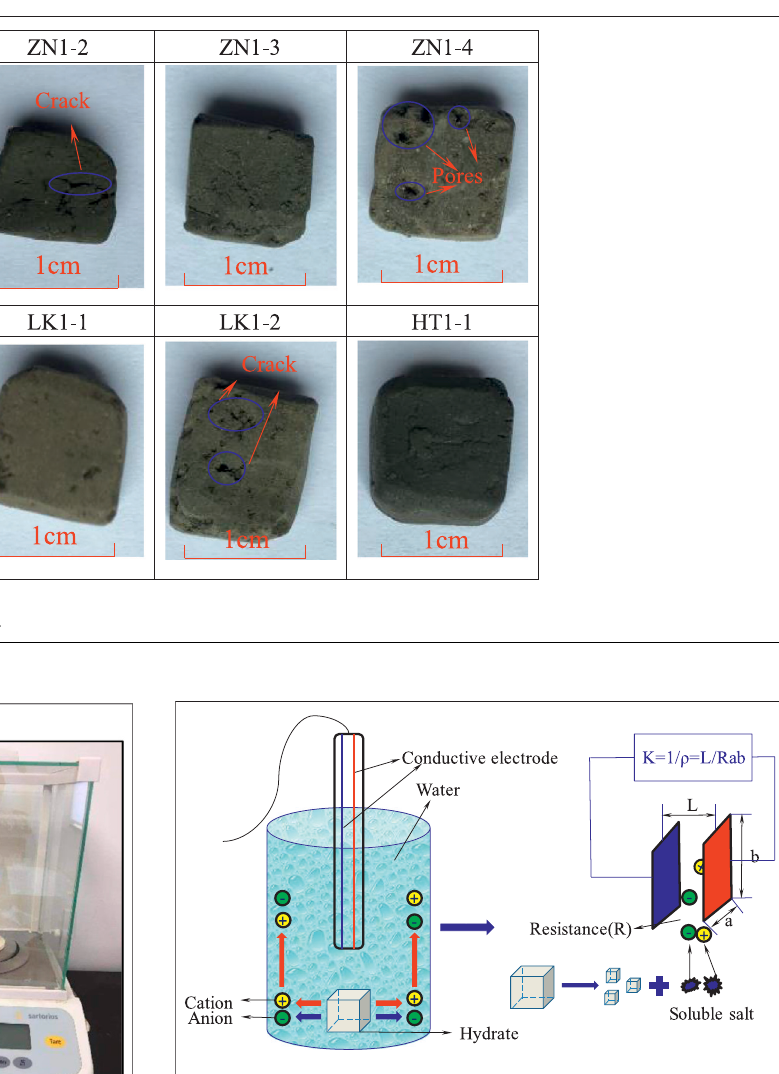
FIGURE 3 | The schematic diagram of the disintegration